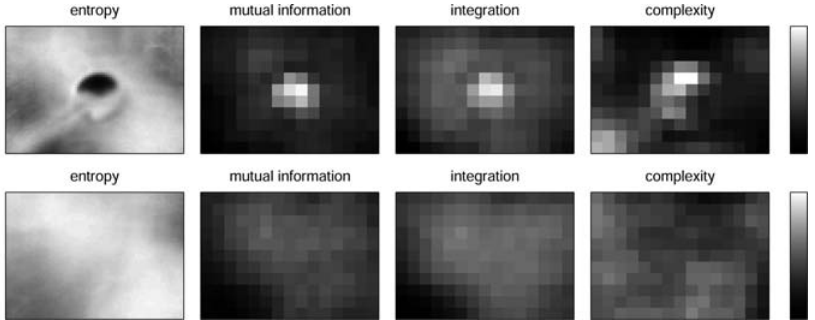
Figure 2. Information Structure in Sensorimotor Data Obtained from Roboto Data represents average profiles obtained from five runs per condition (1,000 time steps each). Resulting maps show (from left to right) entropy, mutual information, integration, and complexity for ‘‘ fov ’’ (A) and ‘‘ rnd ’’ (B) conditions. Gray scale ranges (at right) are [2 4] bits (entropy), [0.35 0.95] bits (mutual information), [23 48] bits (integration), and [0.4 0.65] bits (complexity). DOI: 10.1371/journal.pcbi.0020144.g002 PLoS Computational Biology |